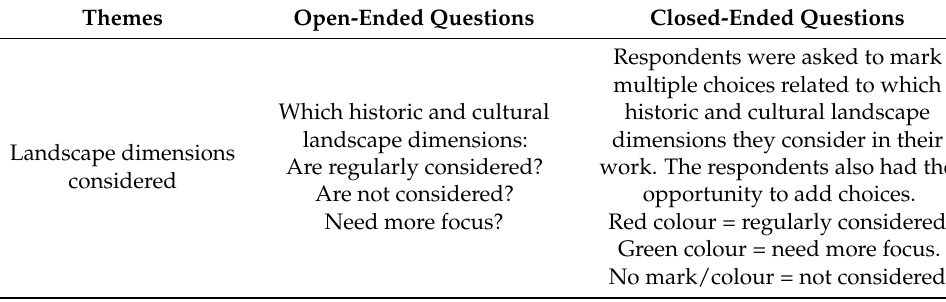
Table 1. Interview instrument—themes and questions that guided the